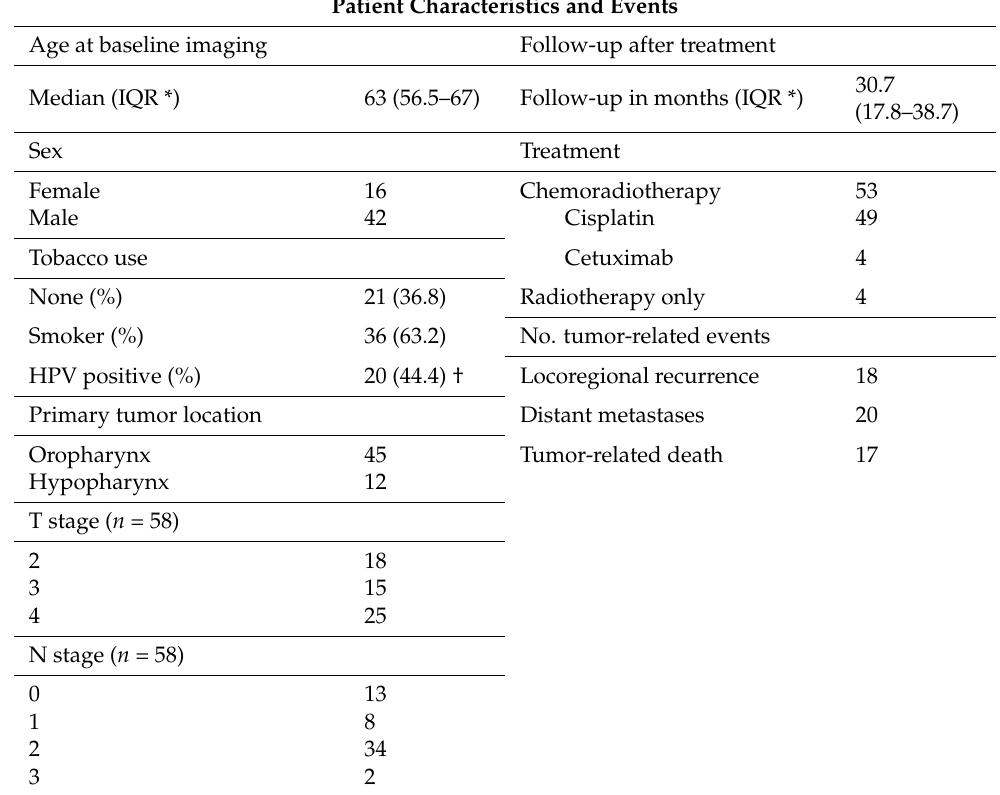
Table 1. Patient